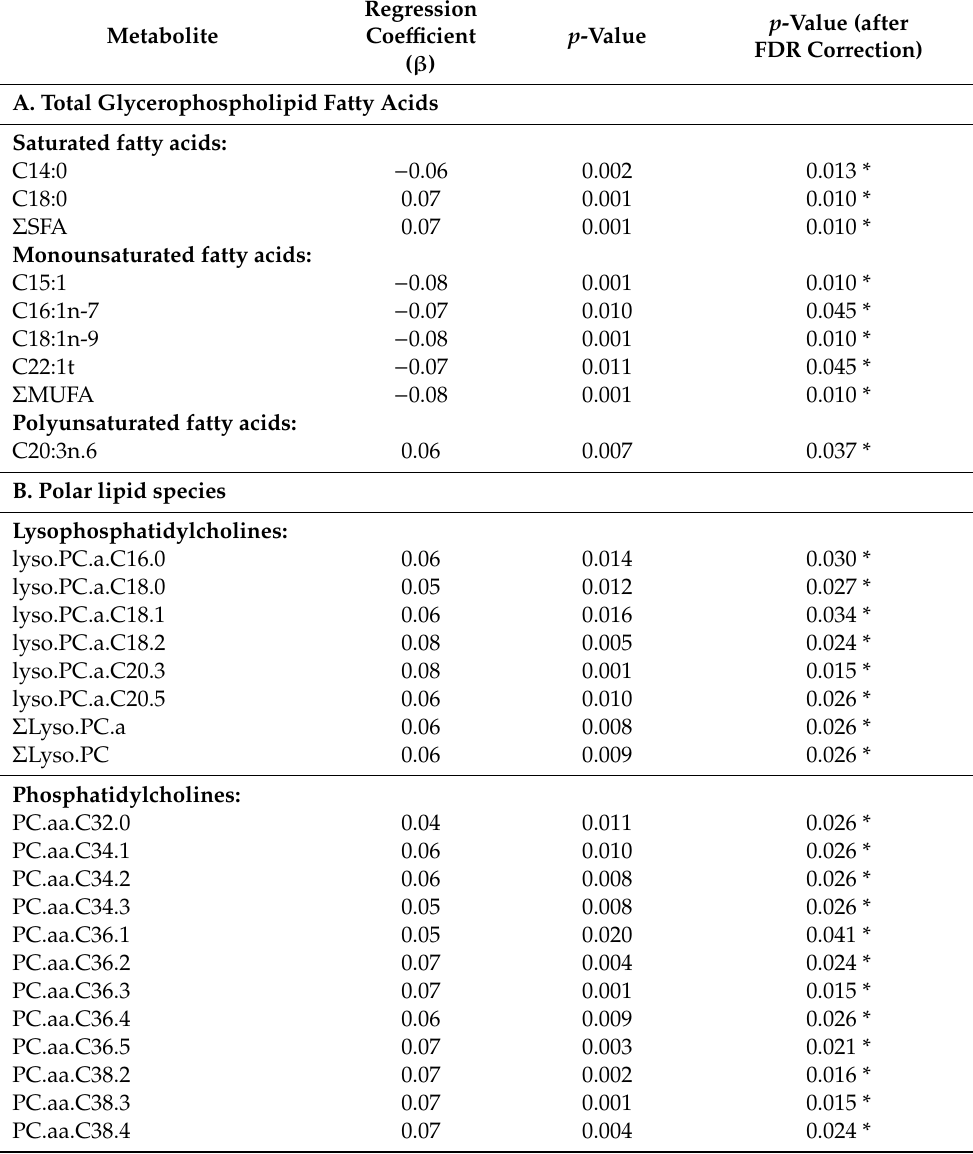
Table 5. Significant results from the linear models for the change in ( A ) total glycerophospholipid fatty acids and ( B ) polar lipid species with child age at baseline in severe malnourished children treated with RUTF. Regression p -Value (after p -Value Metabolite Coe ffi cient FDR ( β )